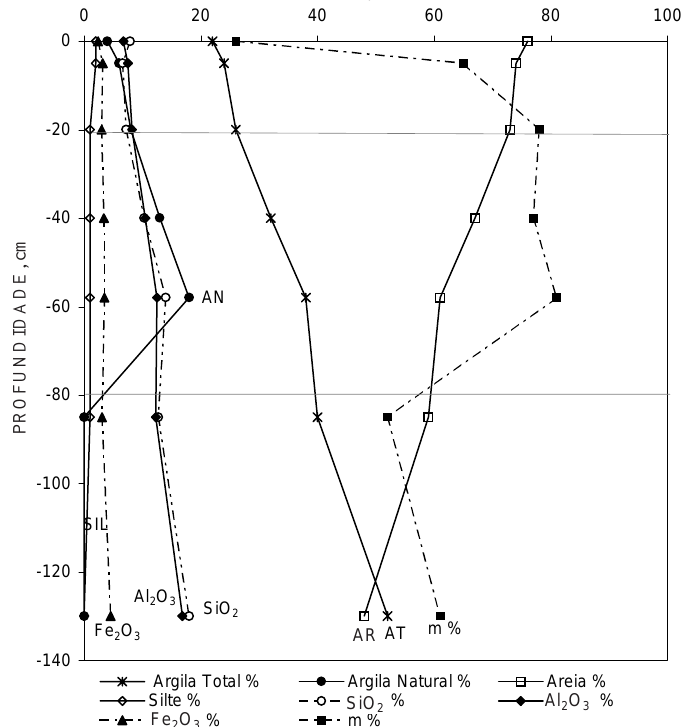
Figura 1. Distribuição em profundidade dos percentuais das frações granulométricas, argila natural, óxidos totais e saturação por alumínio em Latossolo Amarelo Coeso.